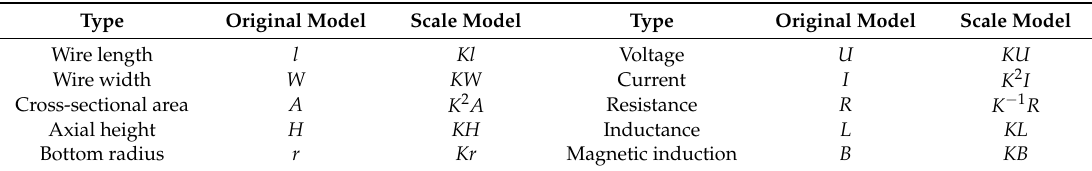
Table 4. Theoretical scaling rules of air reactor parameters.